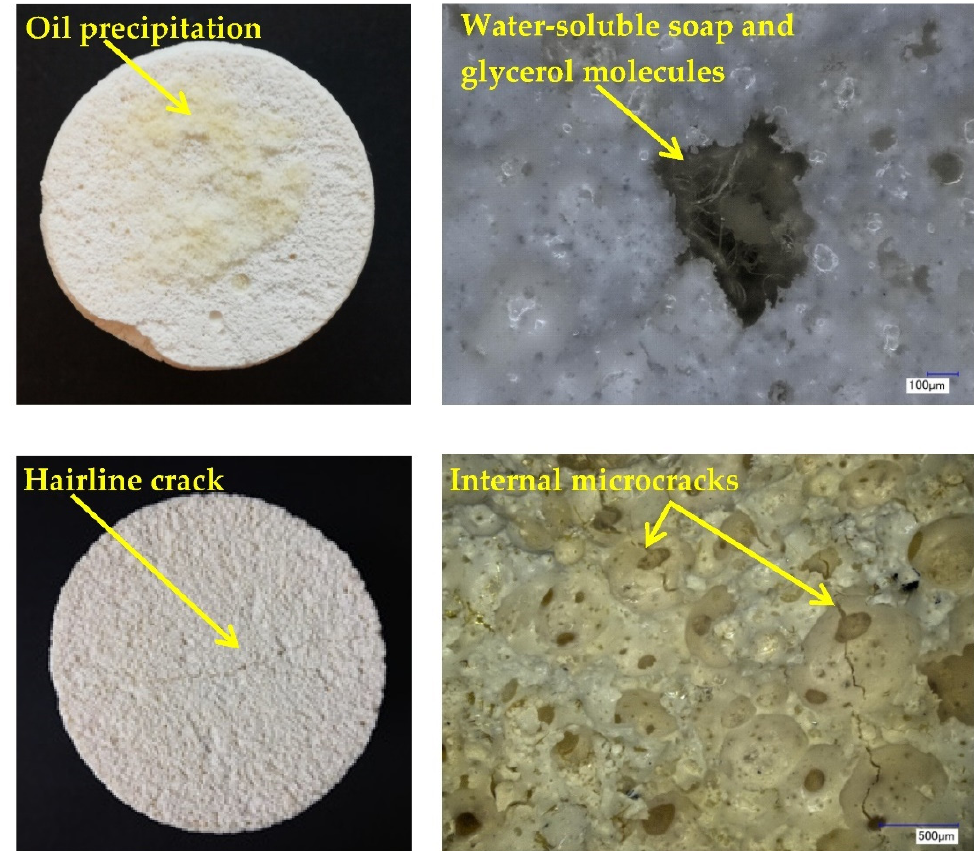
Figure 6. Problems observed during